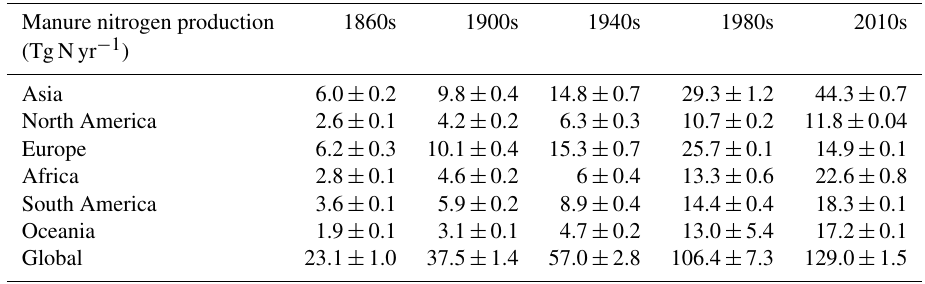
Table 2. Estimates of manure nitrogen production at the continental scale. Manure nitrogen production